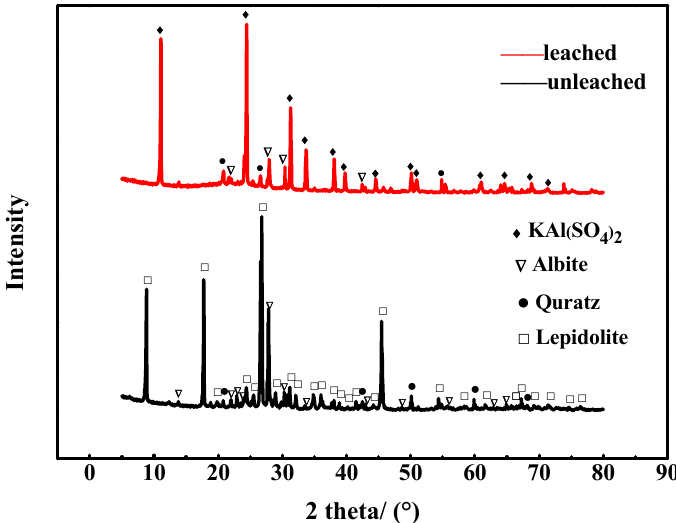
Figure 5. XRD patterns of lepidolite concentrate powder and leaching residue leached after 4 h.